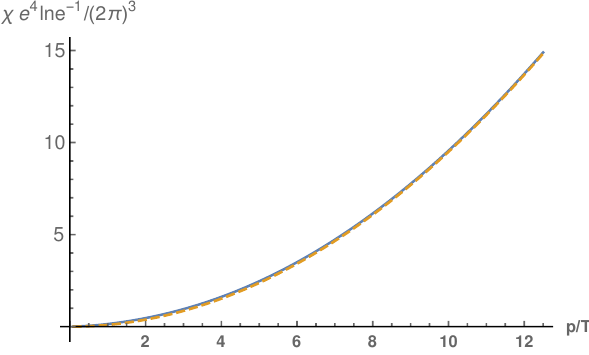
Figure 1 . χe 4 ln e − 1 / (2 π ) 3 versus p/T for massless QED with N f = 2 . Solid and dashed lines cor- respond to numerical solution and approximate analytic solution (2.11). At low p , the approximate solution is slightly below the numerical